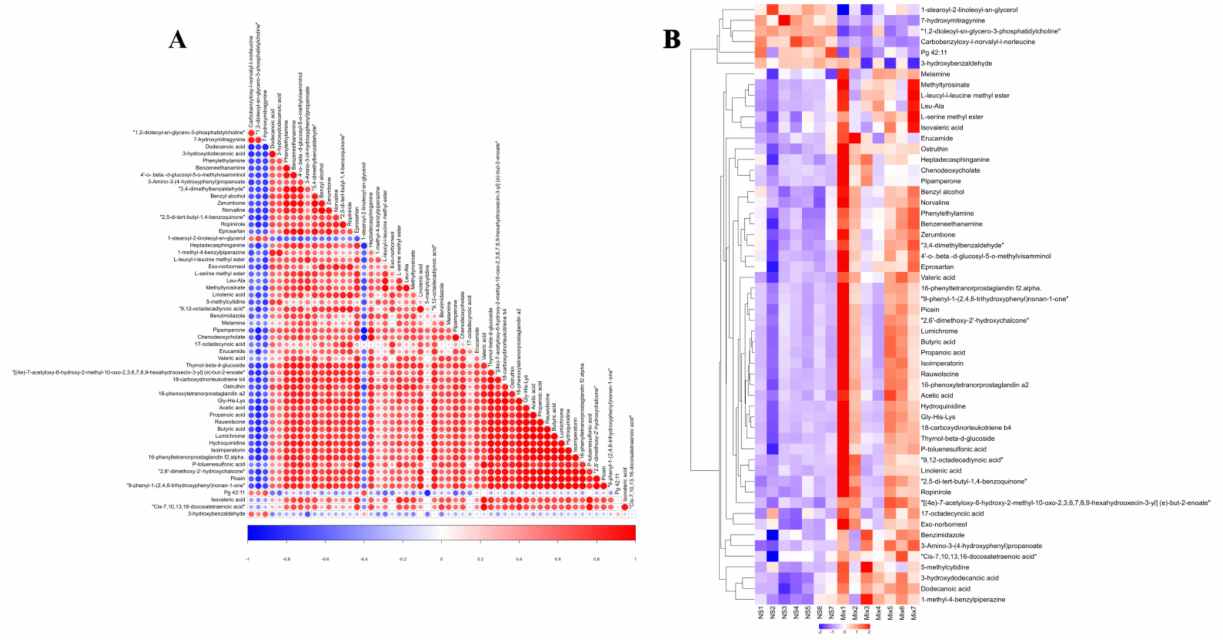
Figure 9. ( A ) Correlation analysis of differential metabolites between NS and Mix group. Red color indicates positive correlation and blue color indicates negative correlation. The higher the value, the stronger the correlation between the two metabolites. ( B ) Heatmap analysis of differential metabolites between NS and Mix group. Red color indicates higher concentration of differential metabolites, blue color indicates concentration of differential